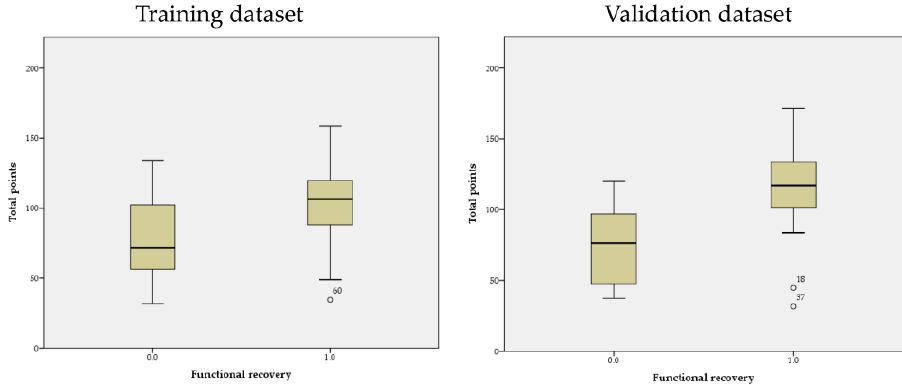
Figure 4. The box plots of score distribution in both event and no-event groups in the training and validation datasets.